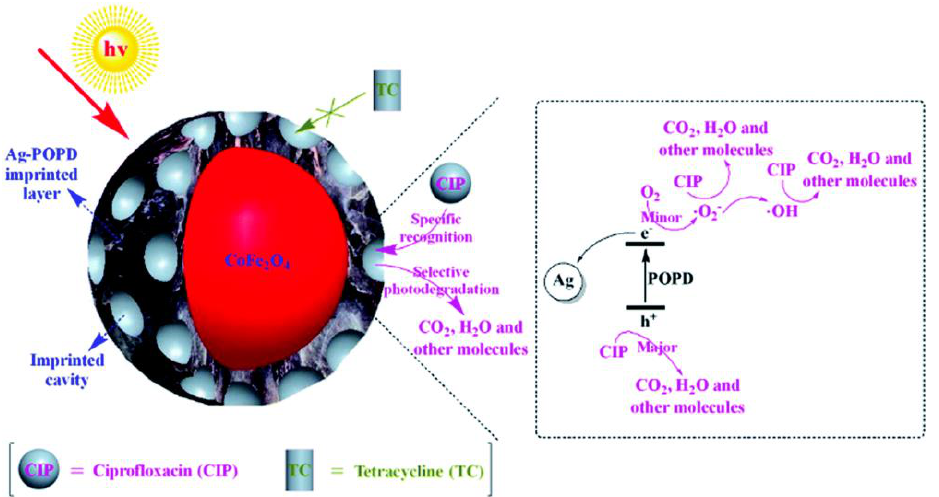
Figure 6. Selective photocatalytic degradation of antibiotics (ciprofloxacin and tetracycline) by imprinted Ag-POPD/CoFe 2 O 4 [51].